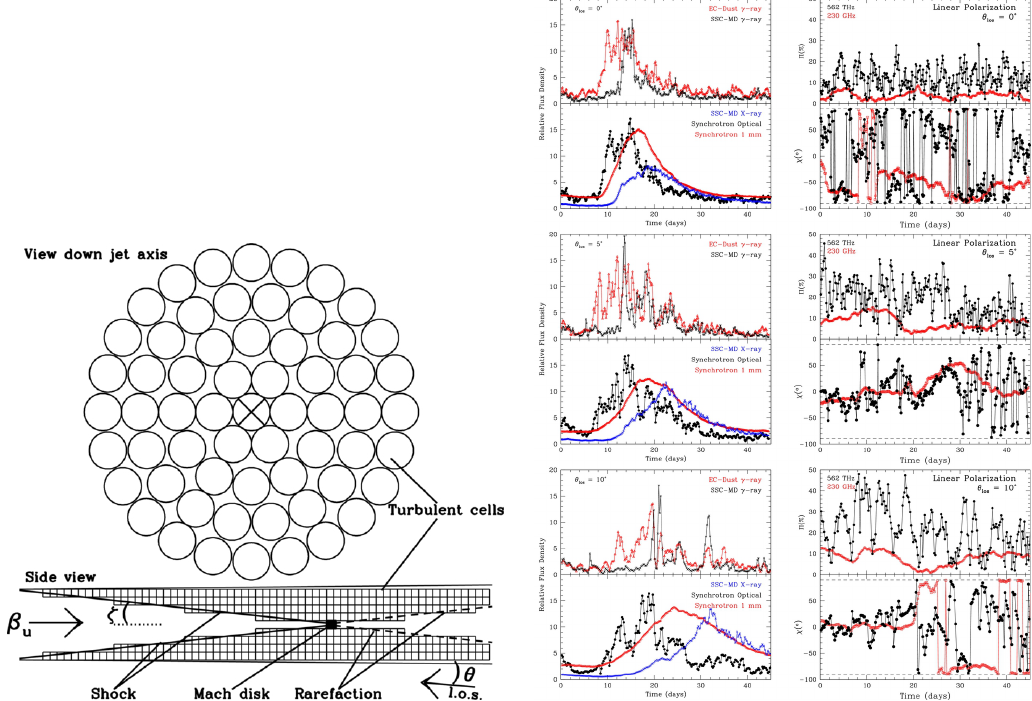
Figure 20. Left : Sketch of the Turbulent Extreme Multi-Zone model. Right : Simulated light curves ( left ) and polarization variability ( right ) for a representative test case of the Turbulent Extreme Multi-Zone (TEMZ) model, for three different viewing angles. From [156]. Reproduced with permission from the American Astronomical Society